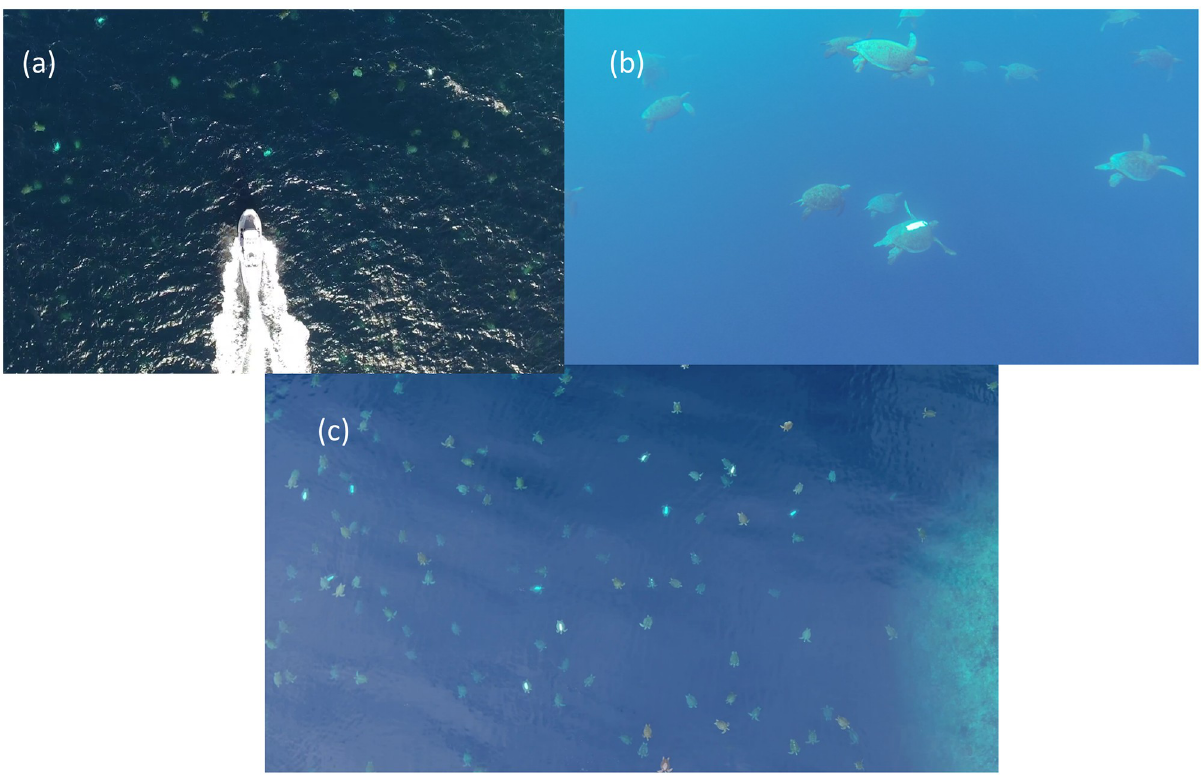
Fig 2. Underwater video and UAV survey image examples. (a) Still image from UAV survey in conjunction with surface observer and underwater video surveys showing survey vessel and (b) Still image from underwater video December 2017 survey and (c) still image from UAV video survey December 2017 at 50 m survey